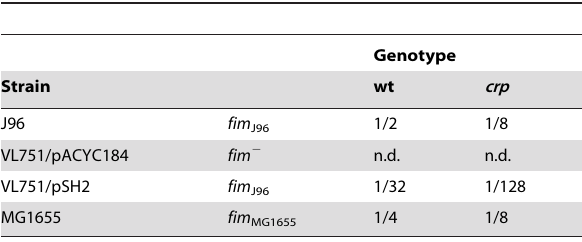
Table 1. Semi-quantitative MSYA in wt and crp derivatives of different bacterial